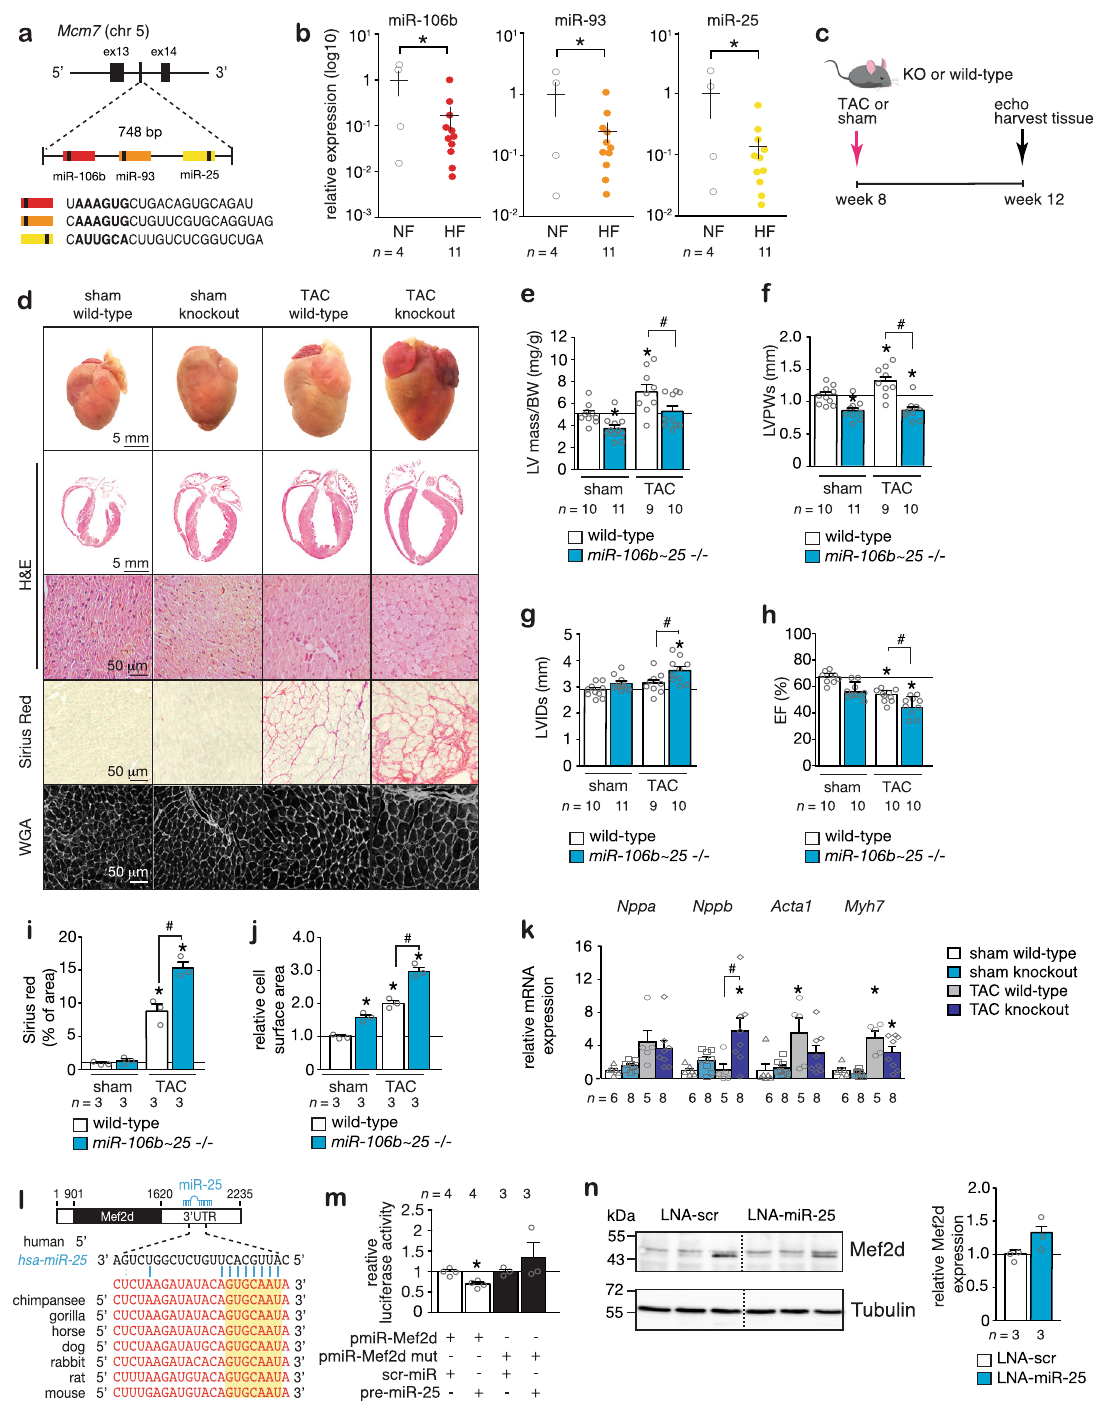
Fig. 1 miR-106b~25 gene deletion induces hypertrophic cardiac remodeling. a A schematic representation of the mouse Mcm7 gene harboring the miR- 106b~25 cluster in intron 13. b Real-time PCR analysis of miR-106b , miR-93 , and miR-25 abundance in human non-failing or failing myocardium. c Design of the study. d Representative images of whole hearts (top panels), haematoxylin & eosin (H&E)-stained sections of four-chamber view (second panel), high magni fi cation H&E sections (third panel), Sirius Red stained sections (fourth panel), and wheat germ agglutinin (WGA)-stained ( fi fth panel) histological sections. Quanti fi cation of e left ventricular mass/body weight (BW) ratio, f left ventricular posterior wall thickness in systole (LVPWs), g Left ventricular internal diameter in systole (LVIDs), h ejection fraction (EF). i Quanti fi cation of the fi brotic area by Sirius Red staining and j cell surface areas by wheat germ agglutinin (WGA) staining. k Real-time PCR analysis of Nppa , Nppb, Acta1 , and Myh7 , n refers to number of animals. l Location and evolutionary conservation of hsa-miR-25 seed region on Mef2d. m Activity assay of luciferase reporter constructs shows the binding of hsa-miR-25 to the 3 ′ UTR of Mef2d, n refers to number of transfection experiments. n Western blot analysis of endogenous Mef2d and GAPDH as a loading control in hearts from wild type (WT) versus miR-106b~25 knock-out (KO) mice, n refers to number of hearts. * P < 0.05 vs corresponding control group; # P < 0.05 vs corresponding treatment (error bars are s.e.m.). Statistical analysis consisted of a two-tailed Student ’ s t -test ( b , m , n ) or a One-way ANOVA followed by Dunnett multiple comparison test ( e – k ). Source data are provided as a Source data fi le. NATURE COMMUNICATIONS| (2021) 12:4808 |https://doi.org/10.1038/s41467-021-25211-4|www.nature.com/naturecommunications